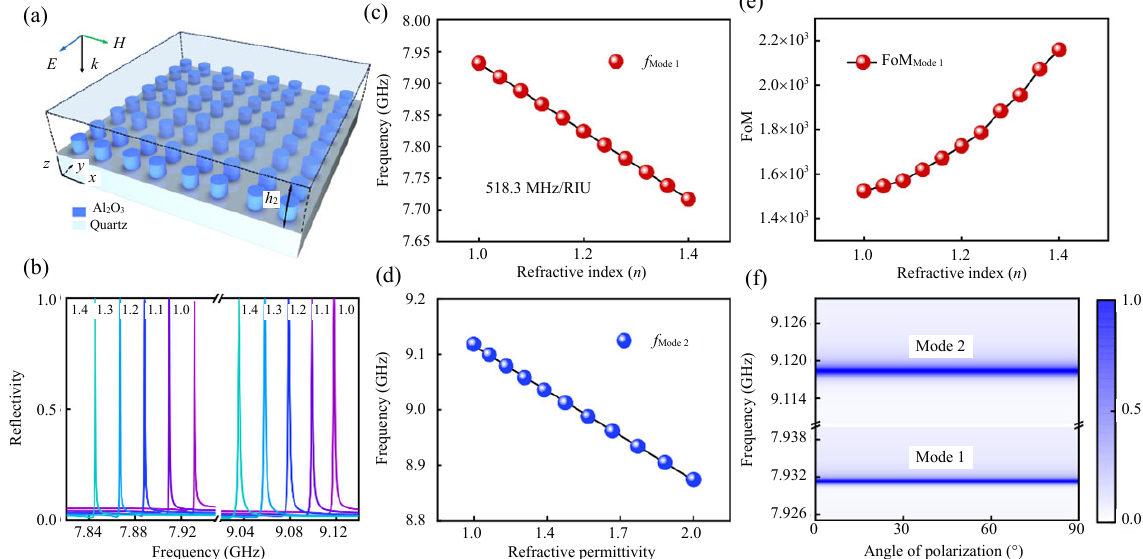
Fig. 7 Metasurface working as ultra-sensitive as refractive index sensor: (a) schematic of GHz ultra-sensitive gas refractive index sensor, (b) reflection spectrum of different refractive index of background medium, (c)–(d) resonant frequencies of the two modes vary with different refractive index of background medium, (e) FoM of modes with different refractive index of background medium, and (f) polarization characteristic of the GHz